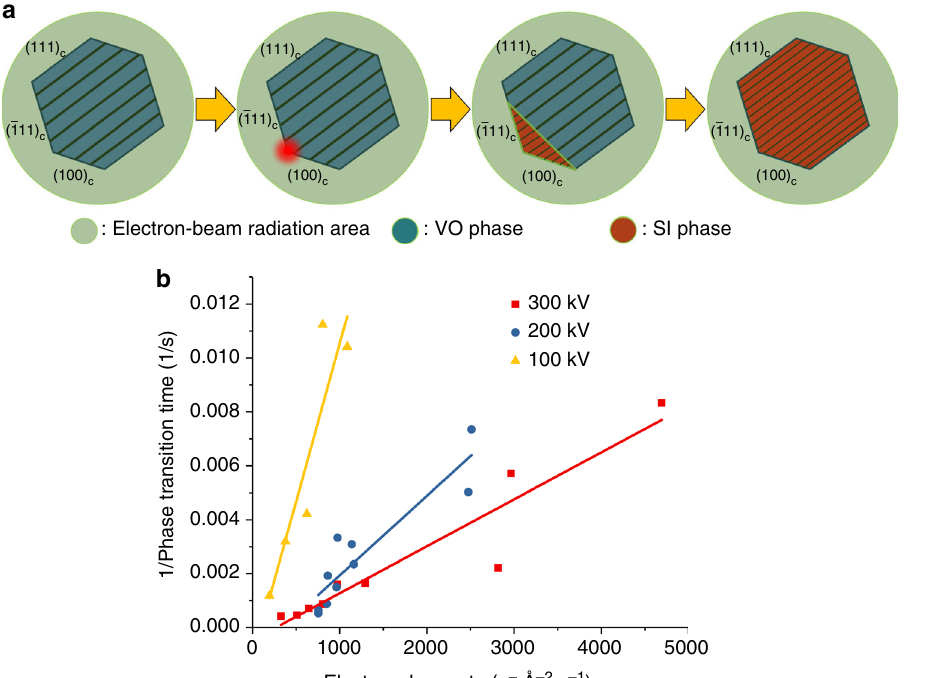
Fig. 2 Spatiotemporal progression of the order – disorder transition. a Schematic of the electron-beam induced transition of the Cu 2 − x Se HNPs from the VO phase to the SI phase. b The speed of the phase transition as a function of the electron dose rate at three different accelerating voltages. The phase transition speed is de fi ned by the inverse of the time it takes from the start of the acquisition for the entire Cu 2 − x Se HNP to transition into the SI phase. Each data-point is obtained from a separate single HNP subject to electron-beam irradiation of a fi xed electron dose rate at a fi xed accelerating voltage. Solid lines are meant to guide the